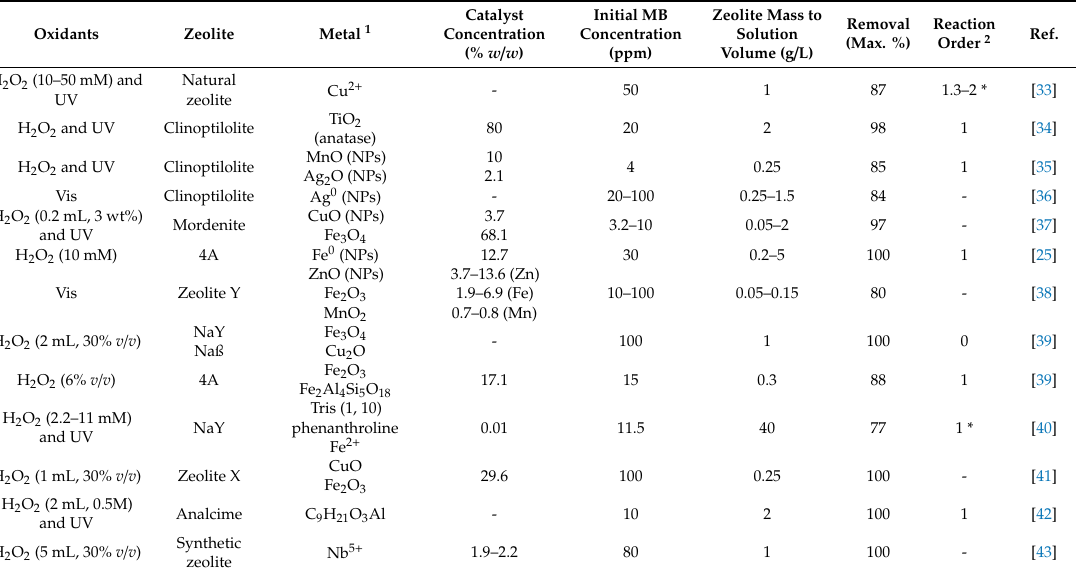
Table 1. Metals-doped zeolites used for the oxidation of the